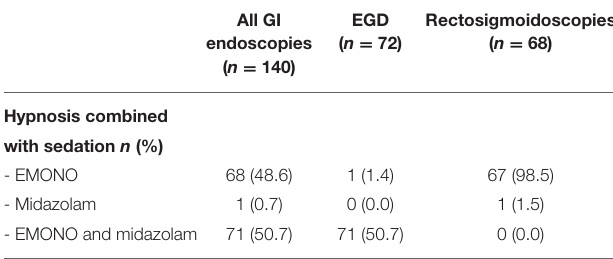
TABLE 2 | Sedation used in combination with hypnosis during gastrointestinal endoscopy in included